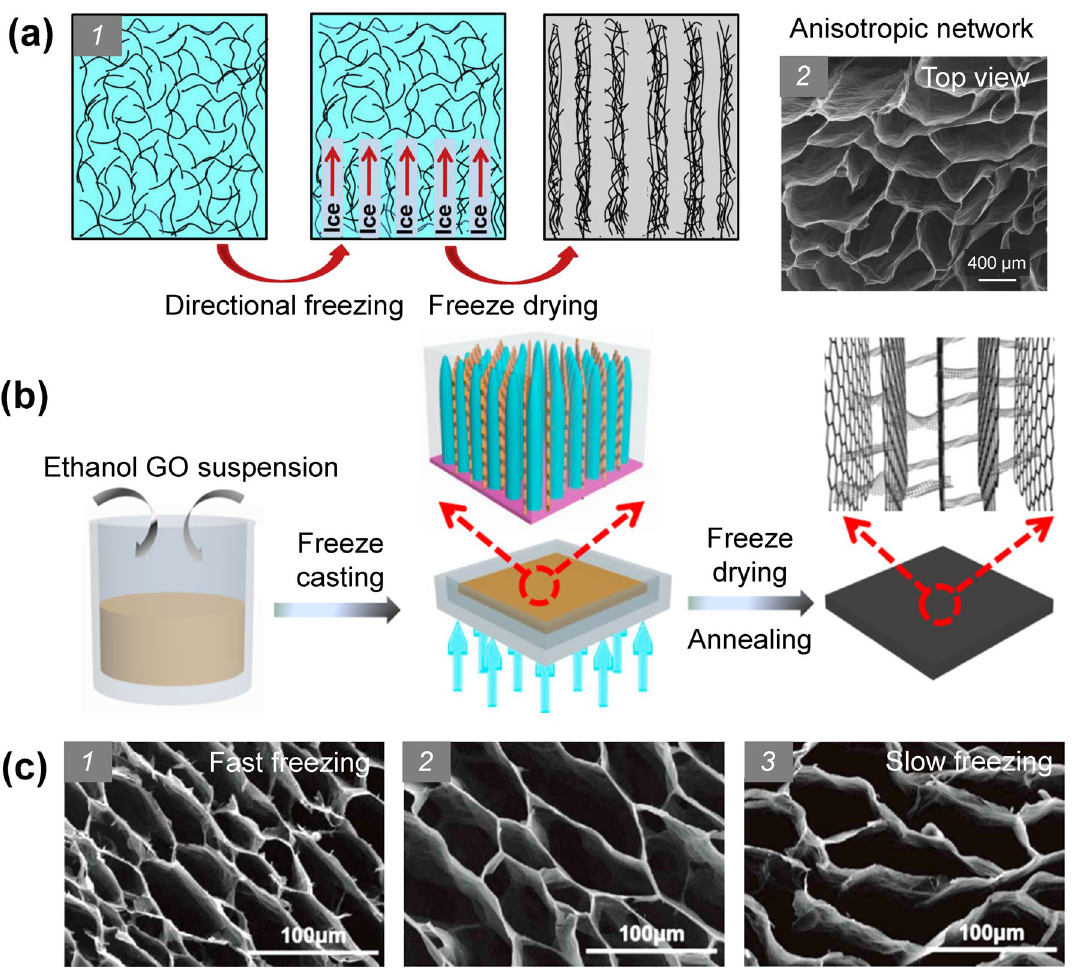
Fig. 10 a Schematic of the microscopic principle of directional freezing [189]. b Schematic of directional freezing of GO suspension and GA structure [192]. c Top‑view SEM images of vertically aligned graphene networks fabricated with freeze‑casting at different freezing rate and subsequent freeze‑drying